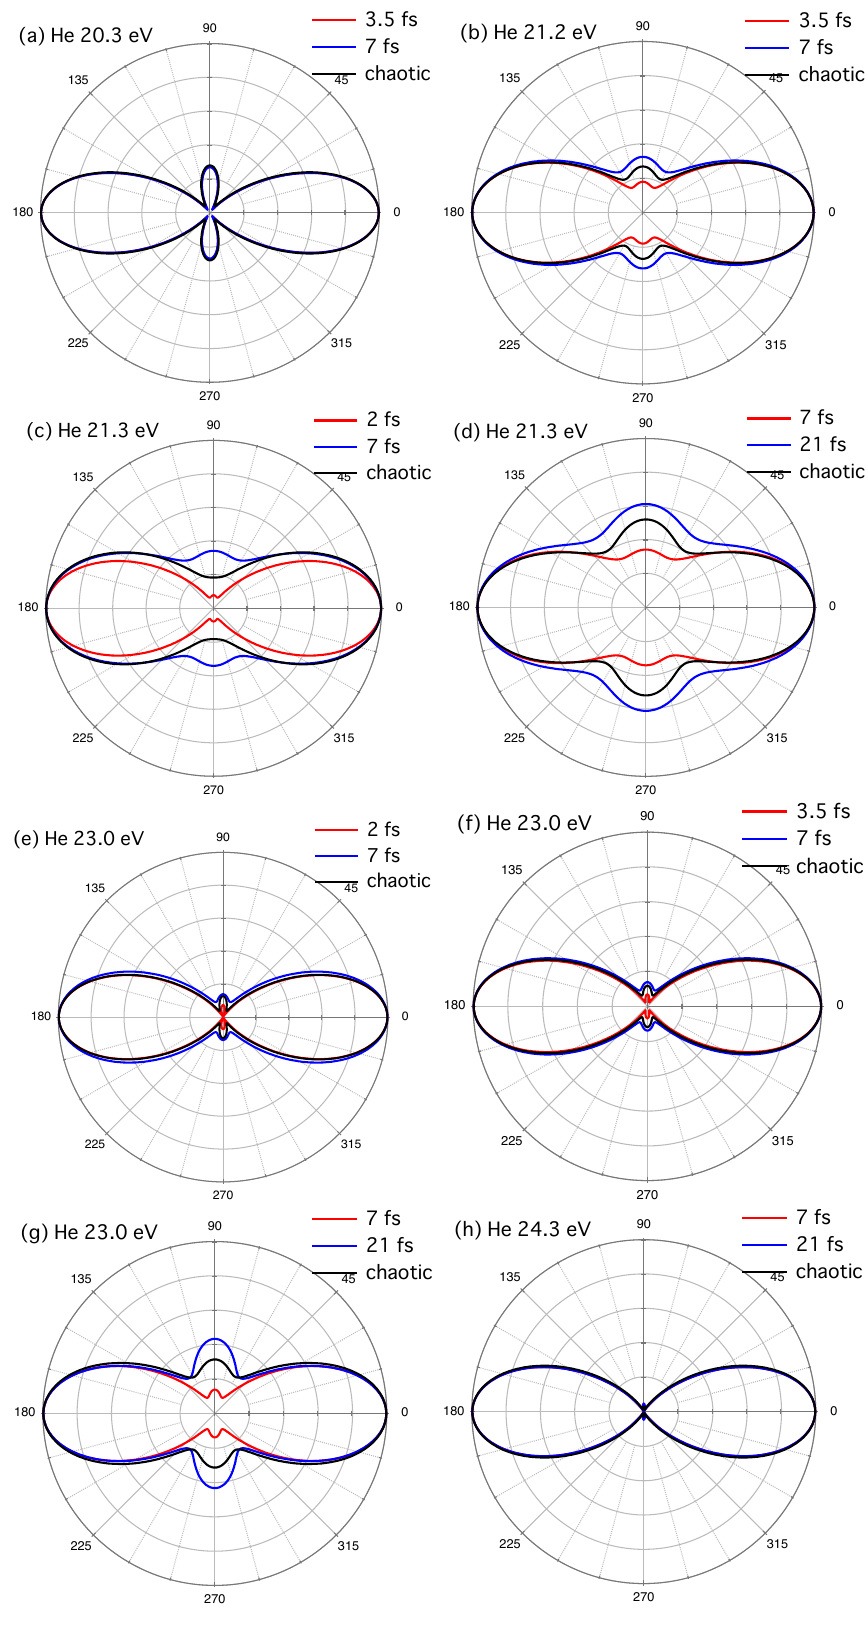
Figure 9. Photoelectron angular distribution by a chaotic pulse for a photon energy, coherence time (CT), and mean pulse width (MPW) indicated in each panel. The target atom is helium. The red and blue curves are for Gaussian pulses whose widths are given by the CT and MPW, respectively of the chaotic pulse. For example, in panel ( b ), the photon energy, CT, and MPW, are 21.2 eV, 3.5 fs, and 7 fs,